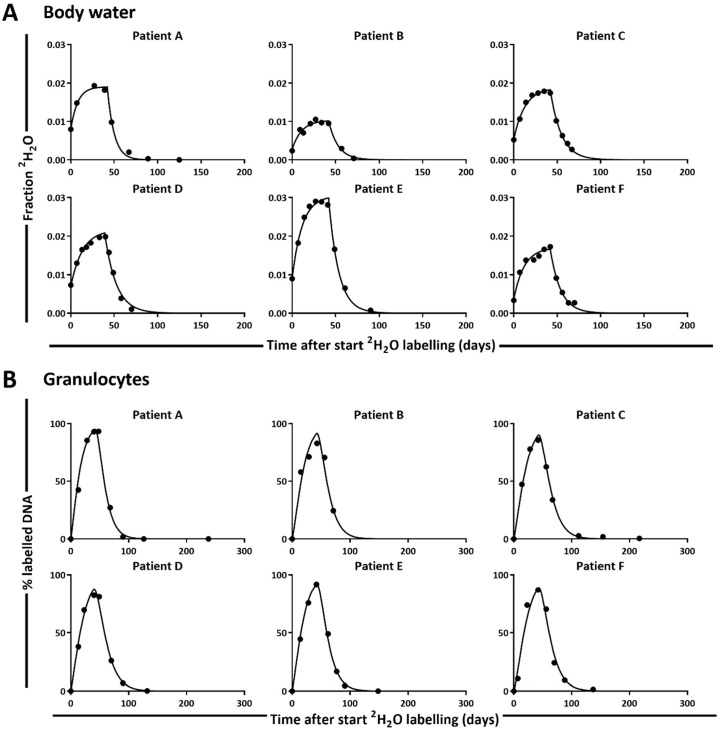
Best fits of 2H enrichment in (A) body water (urine) and (B) granulocytes from the six autologous hematopoietic stem cell transplantation (autoHSCT) patients (A–F).The estimated parameters for urine and granulocytes can be found in Figure 4—source data 1.